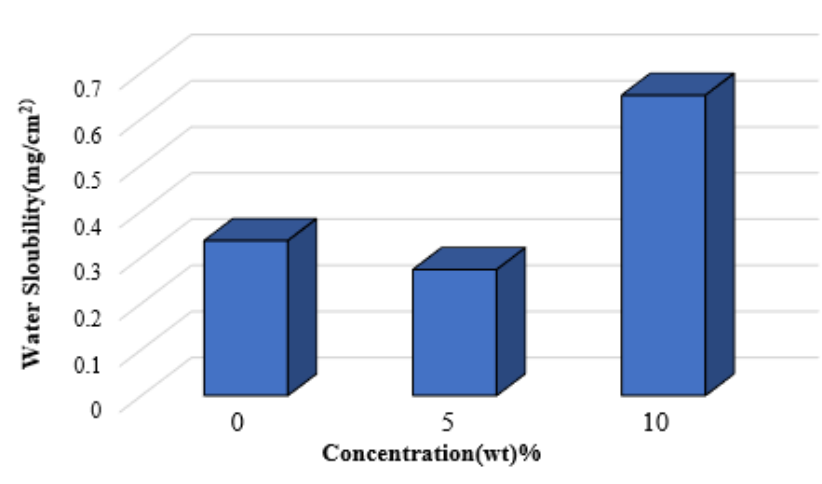
Figure 7: Mean values of water solubility as a function of fiber concentration